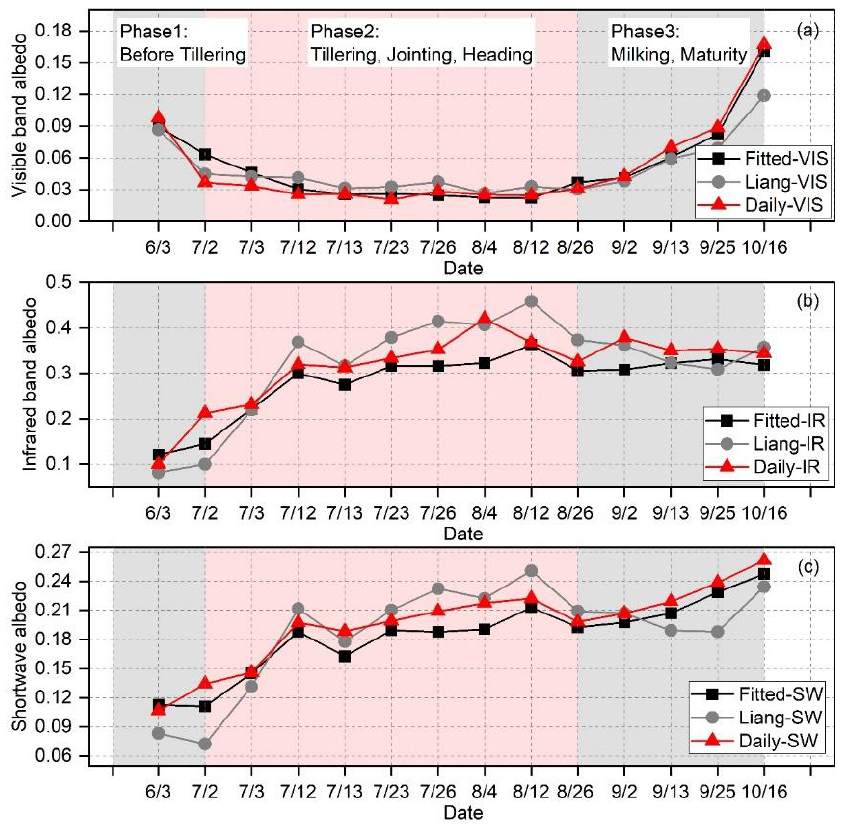
Figure 6. Comparison of the broadband albedo of visible ( a ), infrared ( b ), and shortwave ( c ) bands. Shadows indicate growing phases.